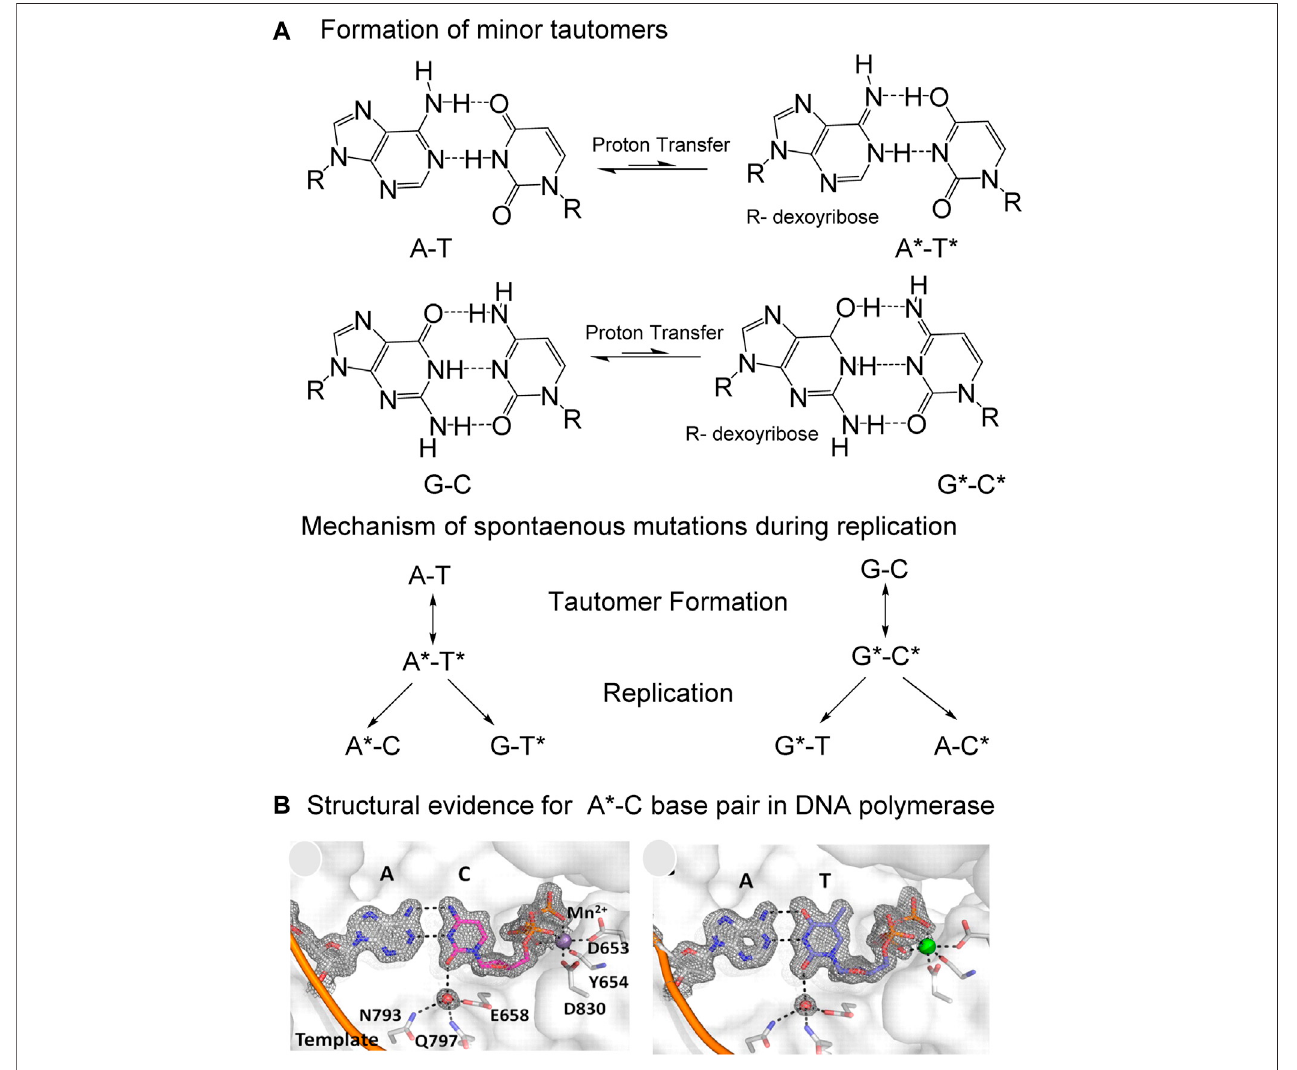
FIGURE 4 | Proposed mechanism by which “ spontaneous ” mutations are introduced by the inter-strand movement of protons in Watson-Crick (W – C) base pairs duringreplication. (A) SpontaneoustransferoftwoprotonsfromonestrandtoanotherinA-TandG-Cbasepairsgenerateminortautomers,whichcanformmismatches duringreplicationtocausemutations. (B) StructuralevidenceforthestabilizationofA-CbasepairinW-Cconformation,almostindistinguishablefromtheA-Tbasepairin active site of a high fi delity DNA polymerase. Figure is adapted from reference (Wang et al., 2011; Slocombe et al., 2021).